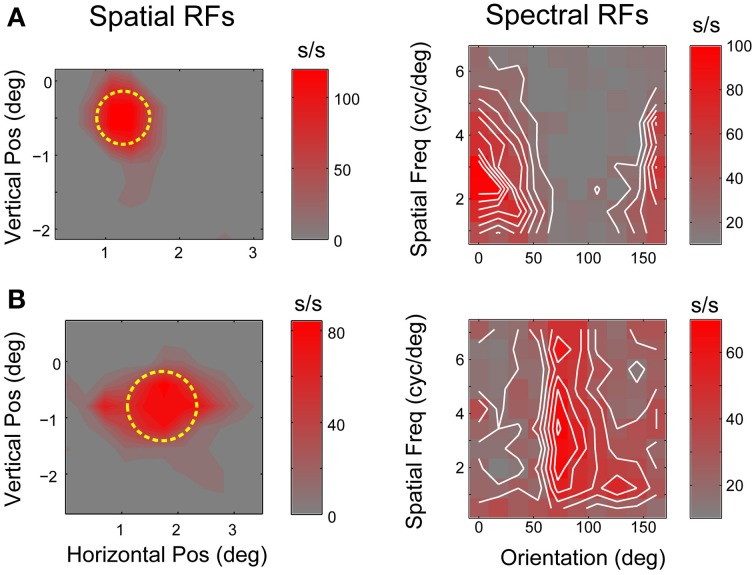
V4 linear receptive fields. (A,B) Spatial and spectral receptive fields for two typical V4 neurons. Left panels show spatial RFs estimated by reverse correlation of responses to black and white probe stimuli flashed on a randomized grid in and around the receptive field. Yellow circles indicate RF location and extent (see text for details). Right panels show SRFs estimated from responses to sinusoidal flashed grating stimuli. Each plot shows the joint orientation-spatial frequency tuning of a single neuron. Iso-response contours (white lines) are separated by intervals of 10 spikes/s.